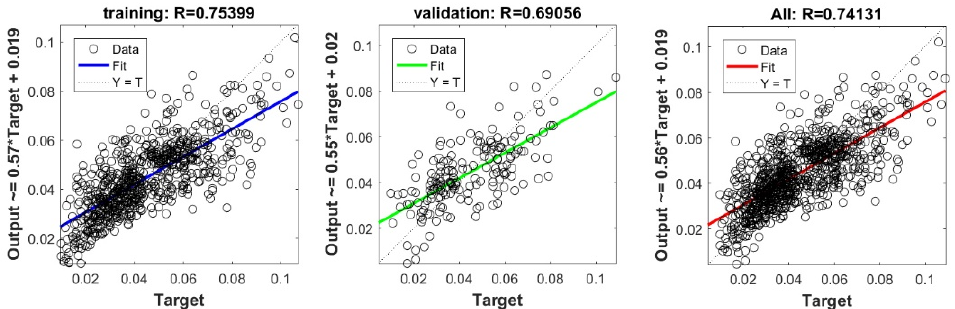
Figure A21. Scatter plots between target and output value by the PSO-DNN model.